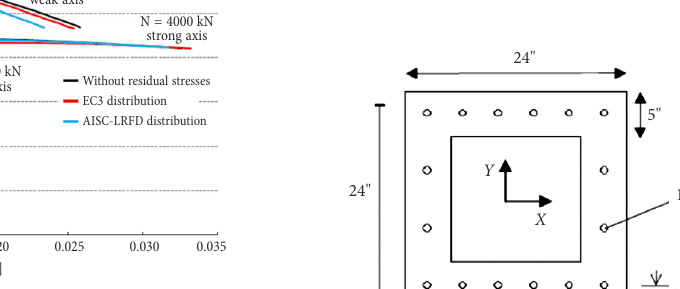
Fig. 14. Moment-curvature analysis for different values of compressive axial loads with and without considering the fillet region effects: Bi-axial bending a = 30 °